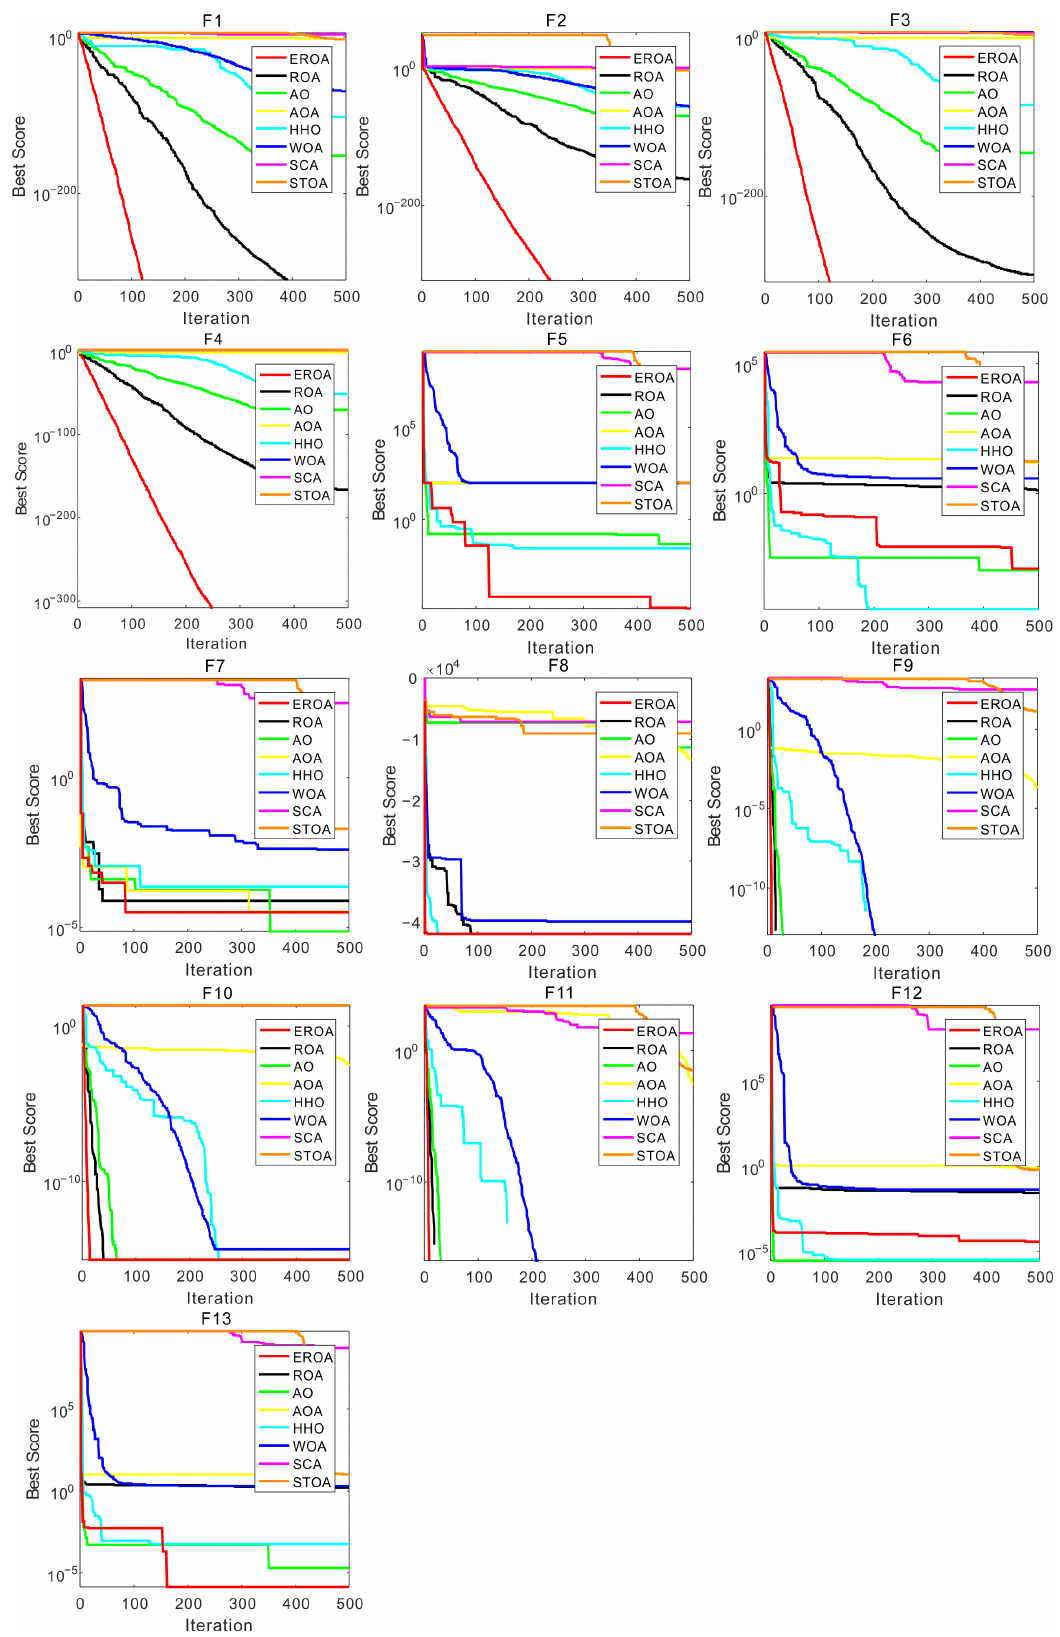
Figure 4. Convergence curves for the optimization algorithms for standard benchmark functions with D = 100.